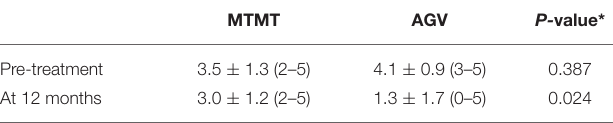
TABLE 5 | Number of topical medications in the MTMT and AGV groups.